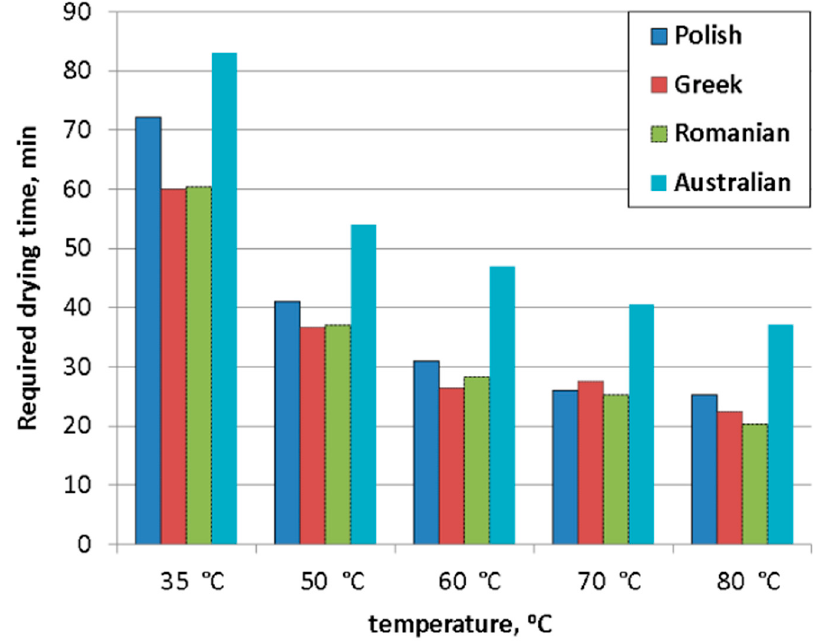
Figure 17. Drying time required to achieve the final moisture content for tested lignites of various origins in the torbed installation.